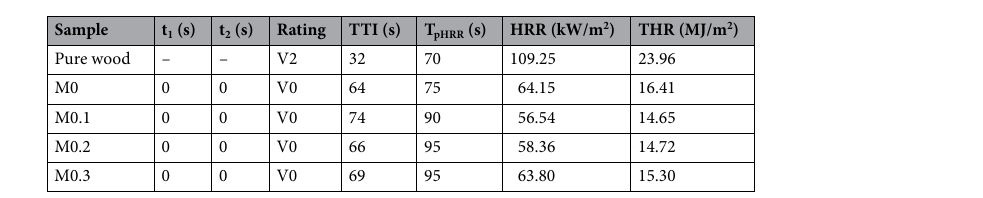
Table 2. The related data of UL-94 and CCT. t 1 , t 2 the first and second after-flame time during UL-94 tests, T pHRR the time of the appearance of